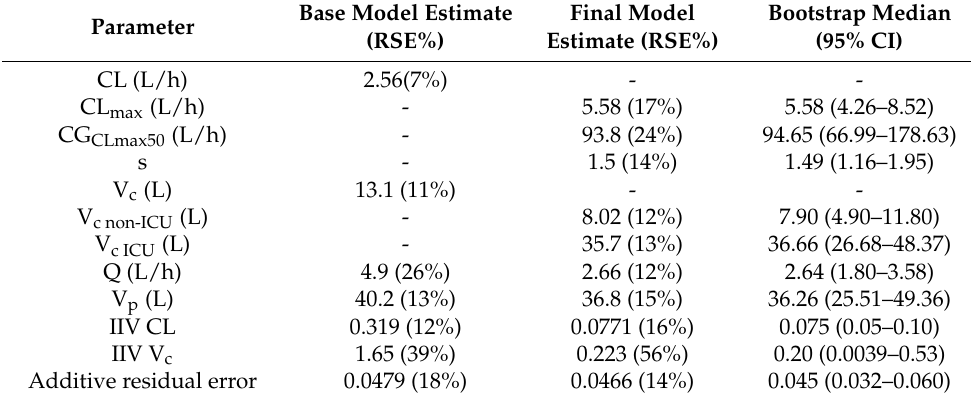
Table 2. Population parameter estimates of the base and final population